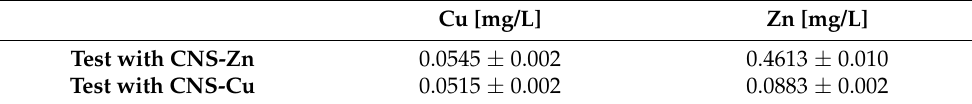
Table 2. ICP-OES analysis results obtained analyzing the methanol solution after a simulated standard synthetic protocol (2 h, methanol, microwave irradiation, 40 ◦ C). For CNS-Cu 6 mg of catalyst in 15 mL of methanol were used, while for CNS-Zn 45 mg of catalyst in 15 mL of methanol were used (quantities selected according to the optimization tests discussed in Section 3).